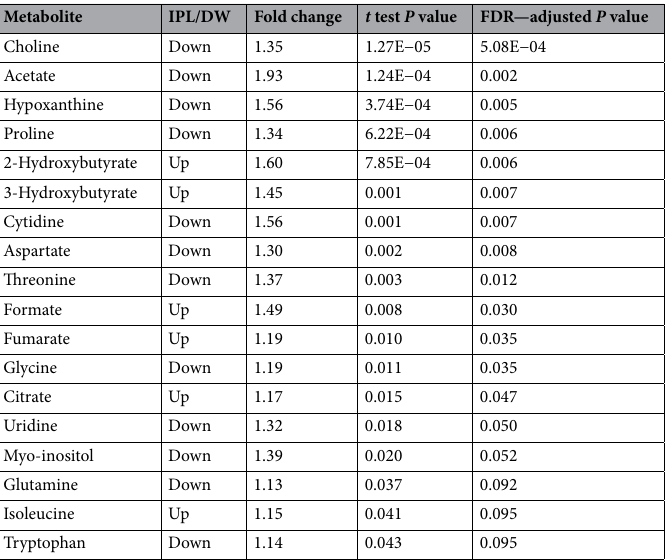
Table 1. Selected Student’s t -test results comparing IPL CpG-ODN to DW control. DW controls n = 18; IPL CpG n = 20. Correction for multiple comparisons was conducted using FDR (n = 40 metabolites). Between- group direction and fold-change of the mean raw metabolite concentrations are also presented. IPL CpG-ODN vs. DW control.